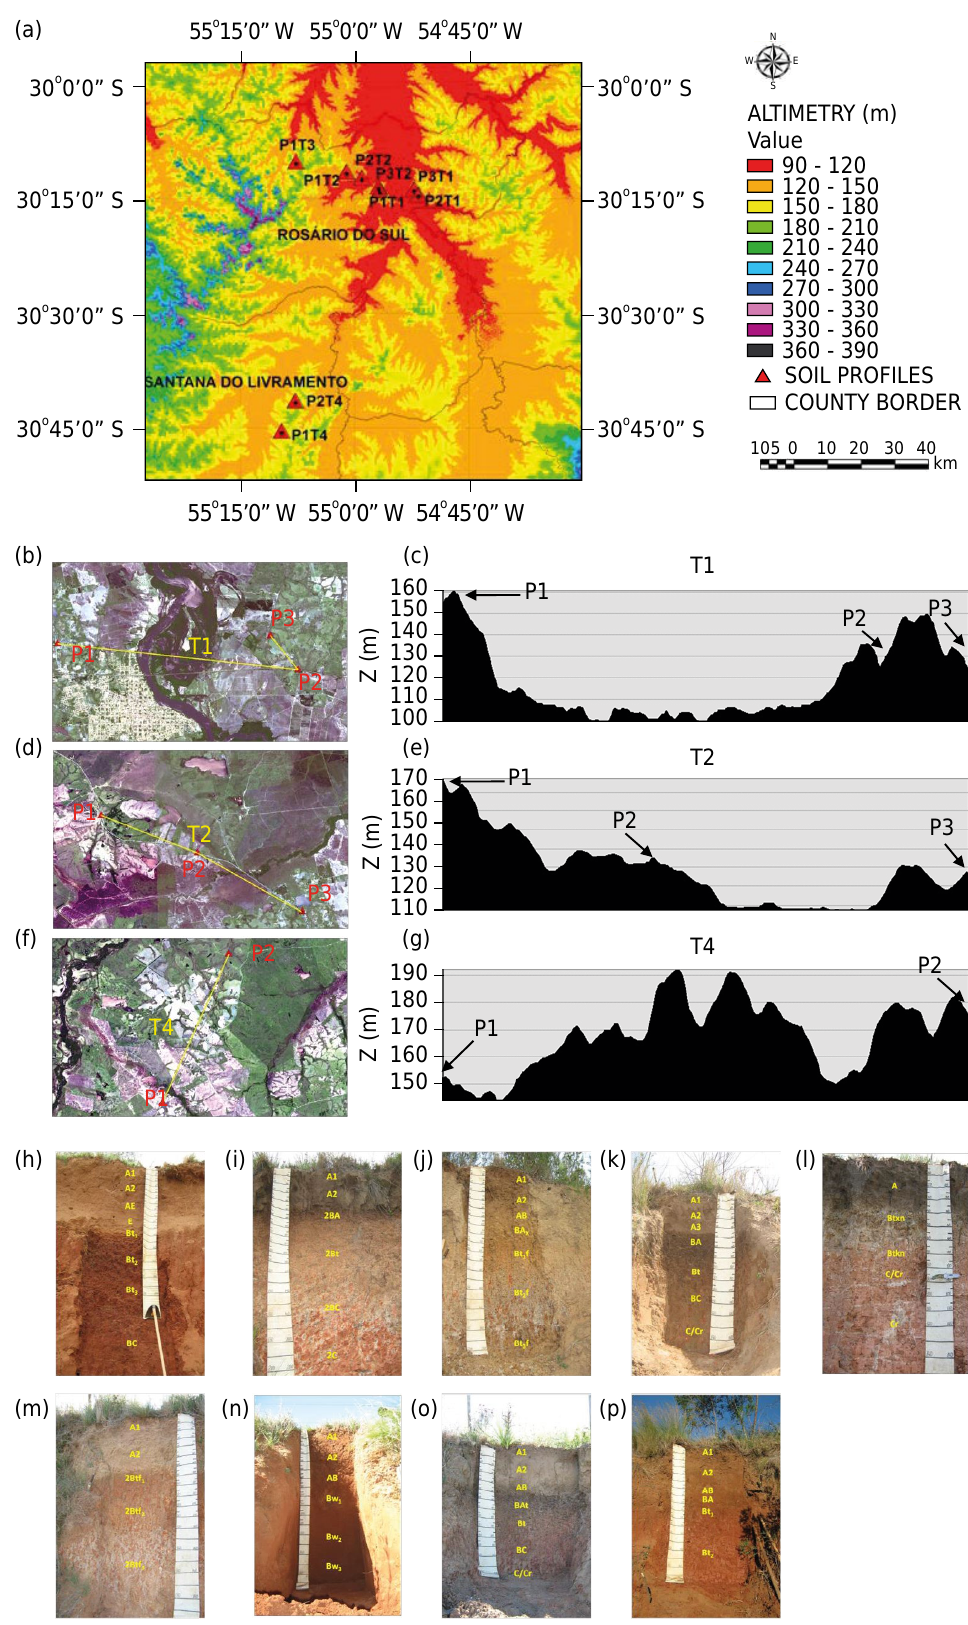
Figure 2. (a) Altimetric map of the region (Datum SAD69 - Scale indicated); T1 (Profiles P1-PVd, P2-PBACal, and P3-PAal), T2 (profiles P1-PBACal, P2-TCk, and P3-FTd), and T4 (profiles P1-TXp and P2-PVd) (RapidEye Image Composition 3R2G1B - without scale); (c), (e), and (g): Topographic profile map of T1, T2, and T4 topolith sequences, constructed from the DEM (without scale); Photographs of soil profiles: (h) P1T1-PVd, (i) P2T1-PBACal, (j) P3T1-PAal, (k) P1T2-PBACal, (l) P2T2-TCk, (m) P3T2-FTd, (n) P1T3-LVe, (o) P1T4-TXp, and (p)